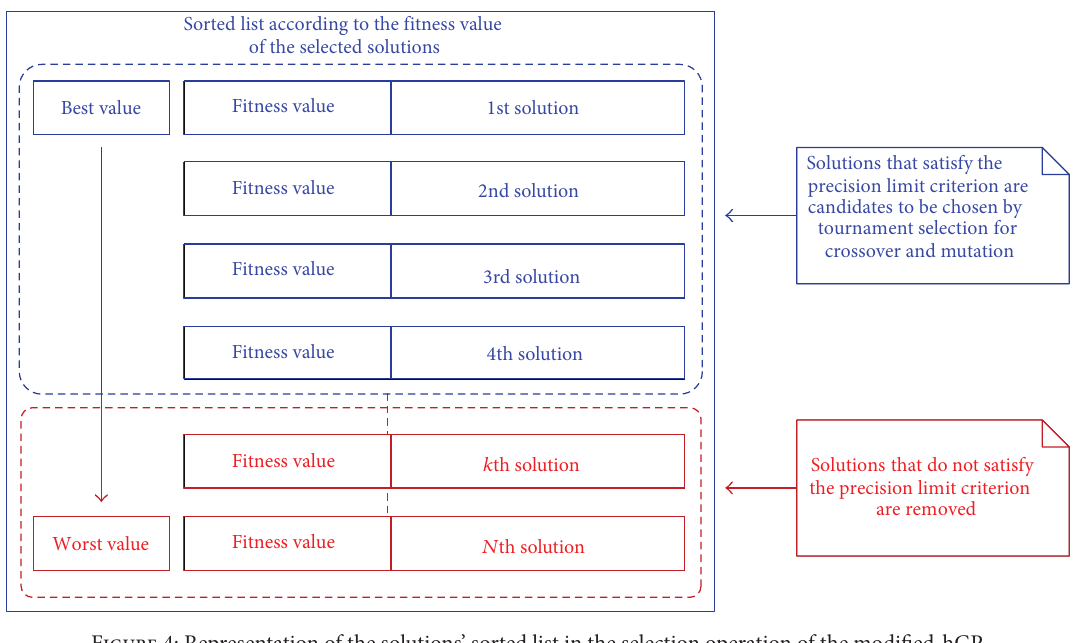
Figure 4: Representation of the solutions’ sorted list in the selection operation of the modified-hGP.